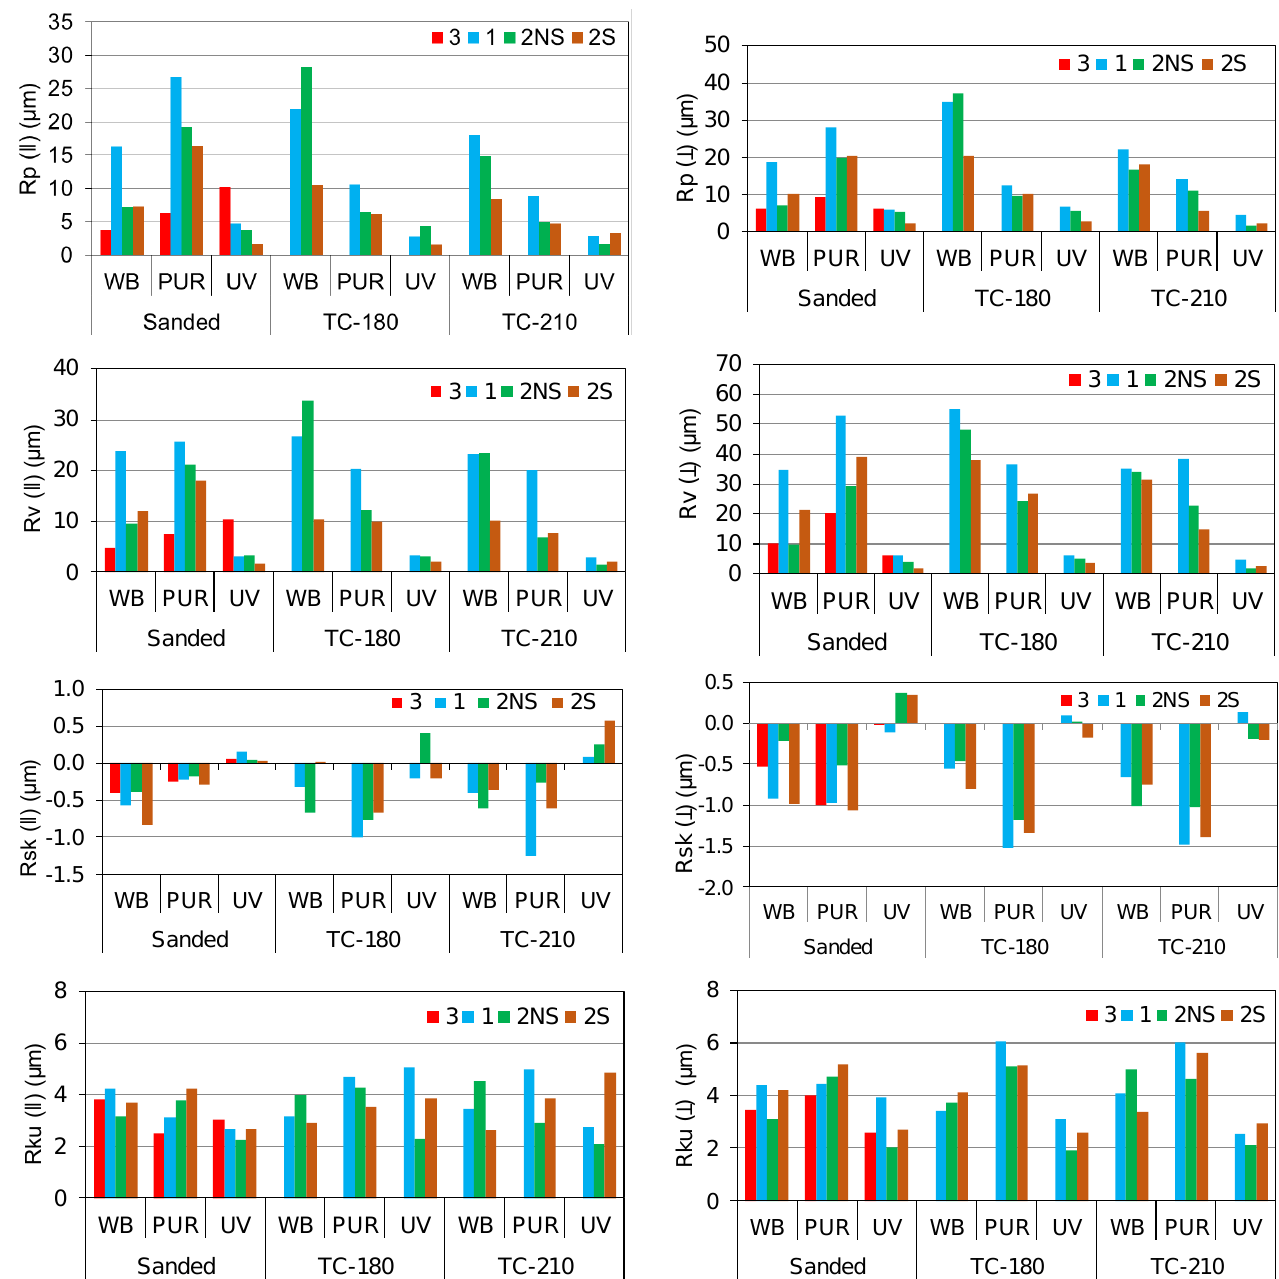
Figure 1. Surface roughness of alder wood samples along and across the fibers. unevenness did not exceed ±10%. Five measurements were taken from the surface of each sample, five along ( ║ ) and five perpendicular ( ┴ ) to the wood fibers. The following pa- rameters of wood surface roughness were evaluated: arithmetic average height ( R a ), aver- age peak-to-valley roughness ( R z ), root mean square ( R q ), maximum peak height ( R p ), maximum valley depth ( R v ), skewness ( R sk ), and kurtosis ( R ku ).